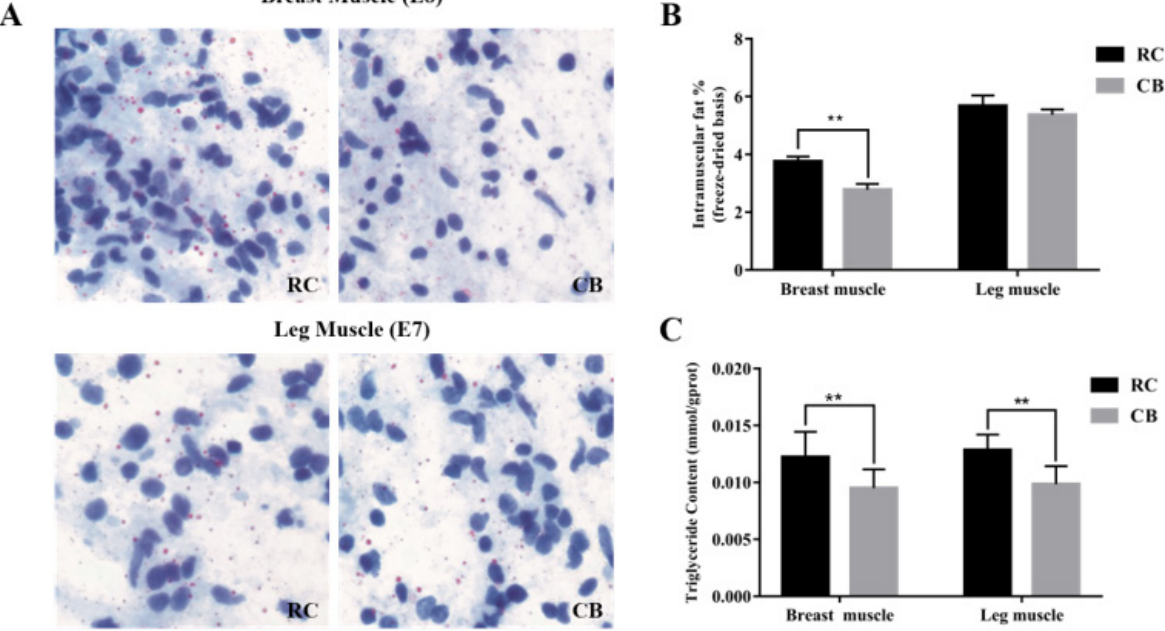
Figure 1. Oil red O staining and determination of IMF and TG contents. (A) Oil red O staining of compression slices of RC and CB breast (E8) and leg muscle (E7) tissue. Lipids were dyed red by oil red O, and nuclei were dyed blue by hematoxylin. Magnification: 40× (B) Comparison of IMF contents in breast and leg muscles between the two chicken breeds. ** Denotes p<0.01. (C) Comparison of TG contents in breast and leg mus - cles between the two chicken breeds. ** Denotes p<0.01. * Denotes p<0.05. IMF, intramuscular fat; TG, triglyceride; RC, rose-crown; CB, Cobb